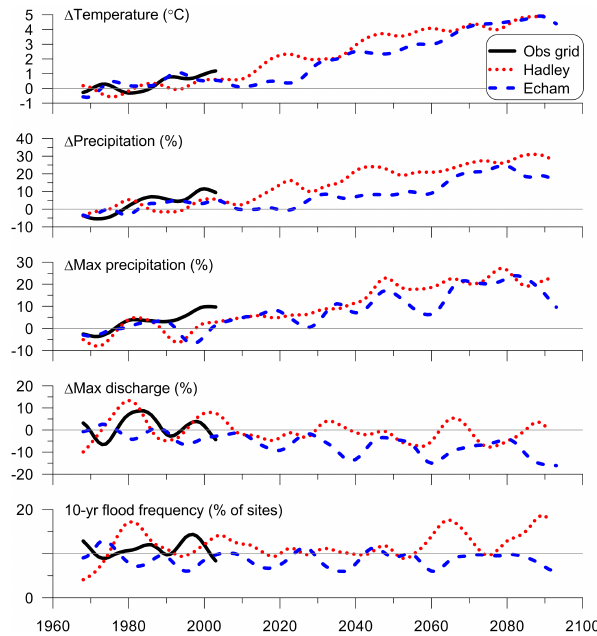
Figure 5. Modeled deviation (%) in annual regional estimates (1961–2100) versus the reference period (1961–1990) using S- HYPE for annual mean temperature and precipitation, maximum daily precipitation, annual daily high flow, and number of gauges exceeding the 10-year flood. A 10-year Gauss filter was used to fil- ter annual results. Modeling was done with forcing data based on observations (Obs grid; solid lines) or on climate models (Hadley and Echam; dotted and dashed